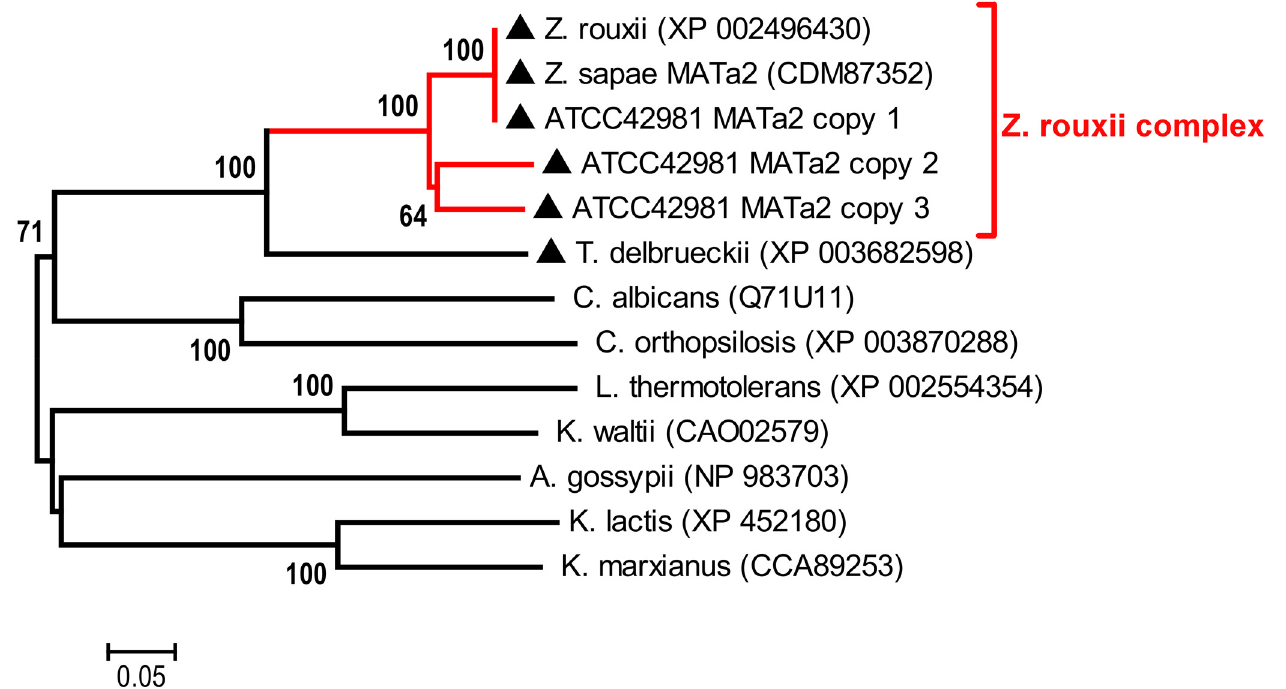
Fig 3. Phylogenetic analysis of MATa2 proteins. The neighbour-joining (NJ) tree shows the phylogenetic relationships between the allodiploid strain ATCC 42981 and other hemiascomycetes inferred from MAT a 2 proteins. Numbers on branches indicate bootstrap support percentages (1,000 pseudoreplicates) higher than 60% from NJ. The red branch indicates the Z . rouxii complex, which includes Z . rouxii MAT a 2, Z . sapae MAT a 2 and ATCC 42981 MAT a 2 copies 1 to 3 sequences. The dark dot indicates WGD species, whereas the dark triangle indicates non-WGD species with the HO gene.